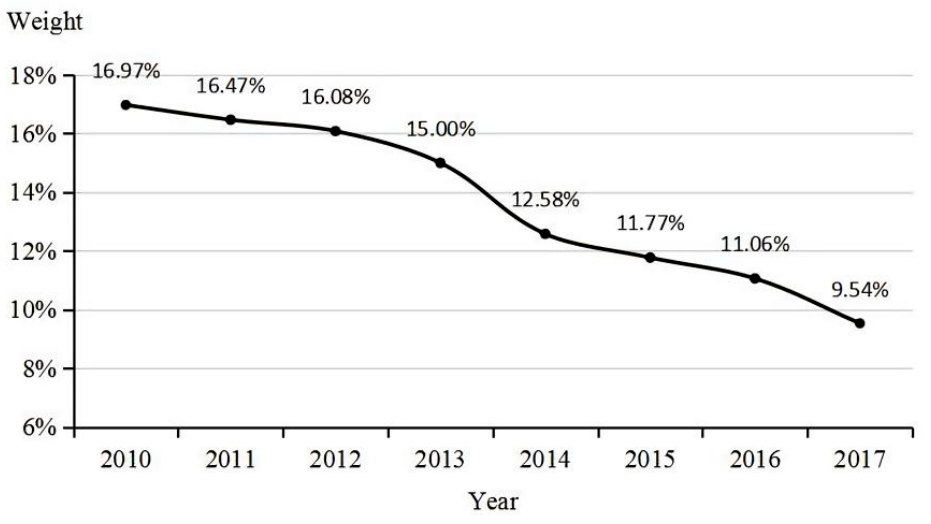
Figure 8. Trend of weight of CO 2 emission density.